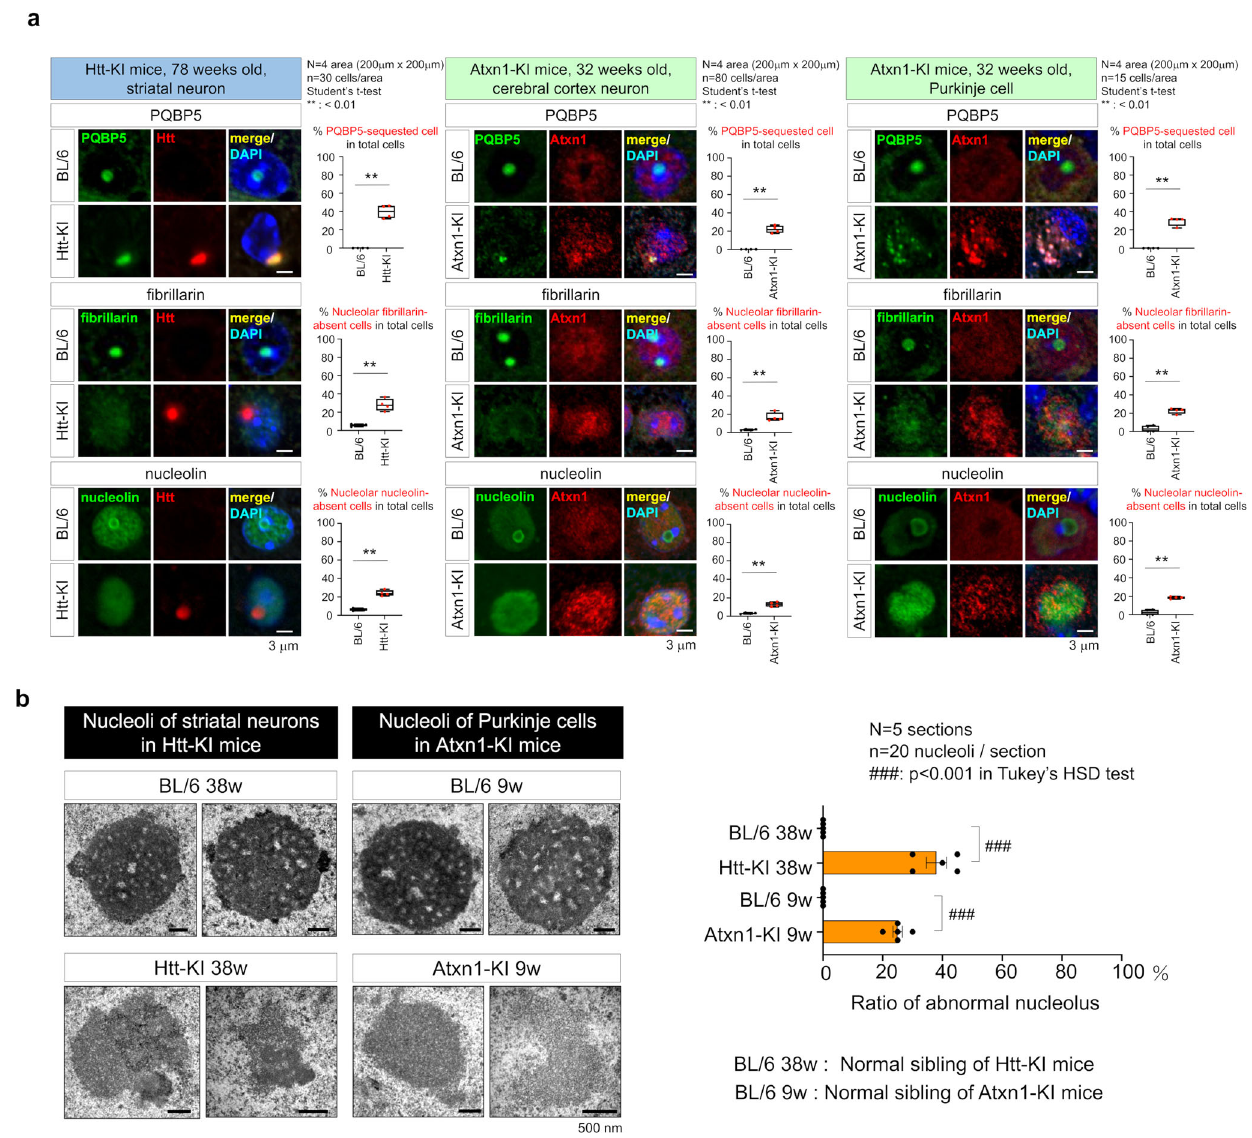
Fig. 7 | Effects of neurodegenerative proteins on PQBP5 and nucleolus decomposition. a Immunohistochemistry of PQBP5 together with normal or mutant polyglutamine disease proteins. PQBP5 was sequestered to the inclusion bodies formed by mutant Htt in the striatal neurons of mutant Htt-KI mice (upper left panels) and in the inclusion bodies formed by mutant Atxn1 in the cortical neurons of mutant Atxn1-KI mice (upper middle panels). In some Purkinje cells of mutant Atxn1-KI mice, PQBP5 was sequestered to cytoplasmic inclusions (upper right panels). In all cases, fi brillarin and nucleolin lost their nucleolar assembly activity. Fibrillarin disappeared from the nucleoli, and nucleolin was dispersed in thenucleus.Therightgraphsintheleftandmiddlecolumnsshowquanti fi cationof PQBP5-sequestered cells (upper graphs), cells lacking nucleolar fi brillarin (middle graphs), and cells lacking nucleolar nucleolin (lower graphs). The box plot shows median, 25 – 75th percentile, and whiskers representing data outside the 25 – 75th